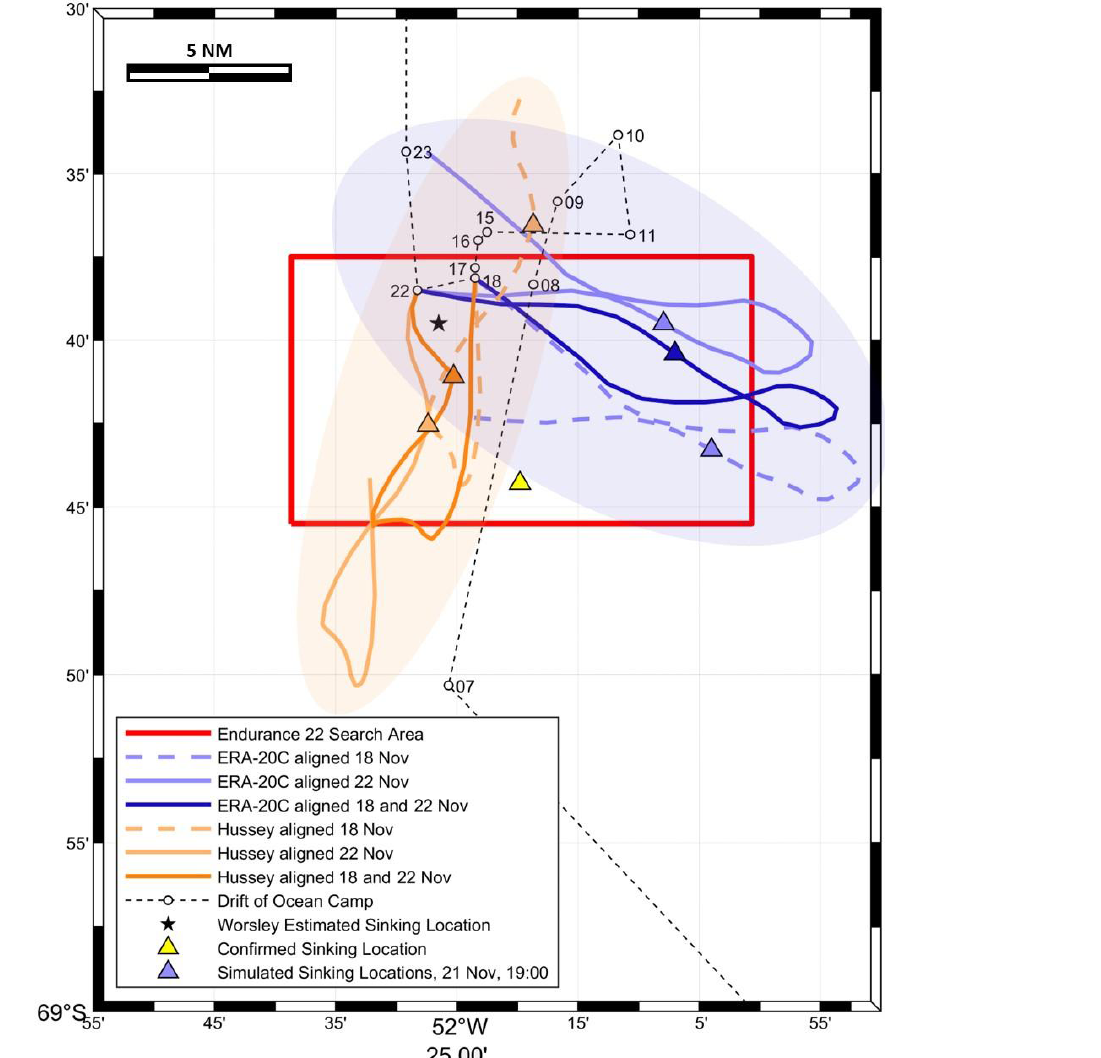
Figure A4. Case 3 reconstructed drift tracks and sinking sites using ERA-20C reanalysis (blue) and Hussy’s meteorological observations (orange). Case 3 utilised a wind drift factor of 2.5% and a turning angle of − 25 ◦ . Coloured ellipses show approximate uncertainty regions associated with the respective